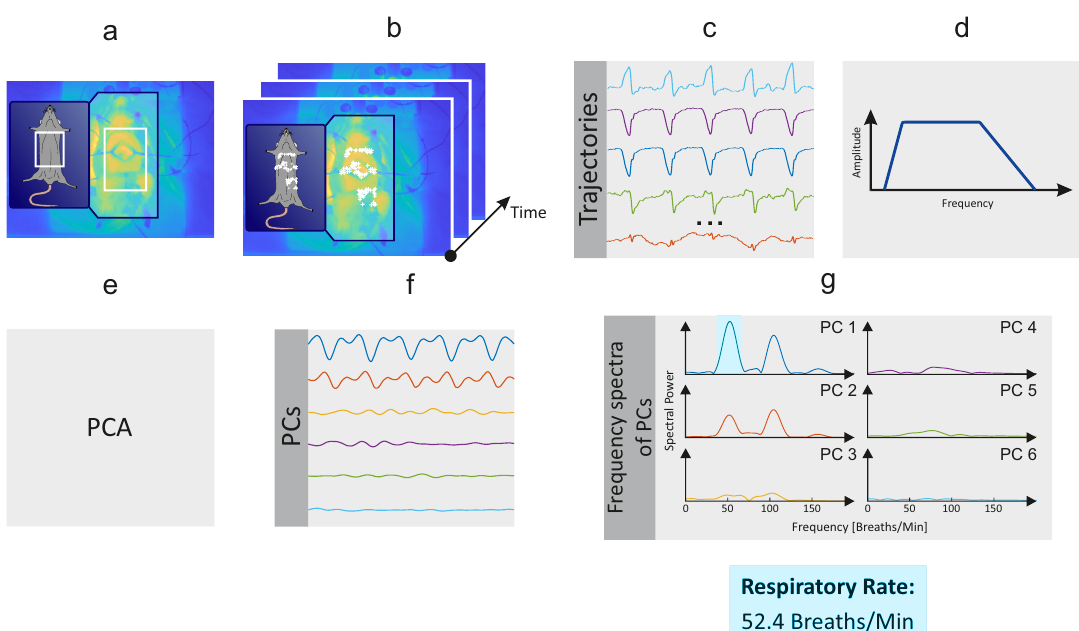
Figure 1. Schematic overview of the RR algorithm. ( a ) Selection of region of interest (ROI); ( b ) Detection and tracking of feature points; ( c ) Extraction of feature points’ trajectories; ( d ) Temporal filtering; ( e ) Blind source separation via principal component analysis (PCA); ( f ) Rank principal components (PCs) based on their variance; ( g ) Computation of frequency spectra and estimation of